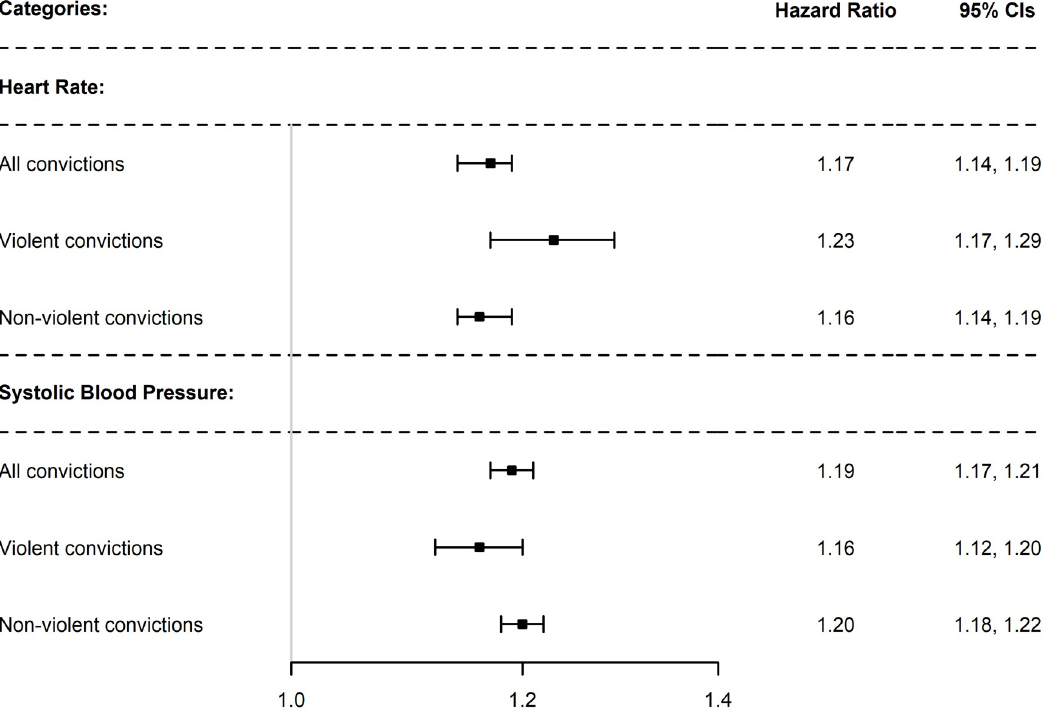
Fig 1. Forest plot displaying hazard ratios and 95% confidence intervals for the associations between resting heart rate and systolic blood pressure with reoffending. Estimates represents comparison between convicted males in the lowest quintile and convicted males in the highest quintile. Models are adjusted for birth year, age at first crime, SES, height, weight and physical